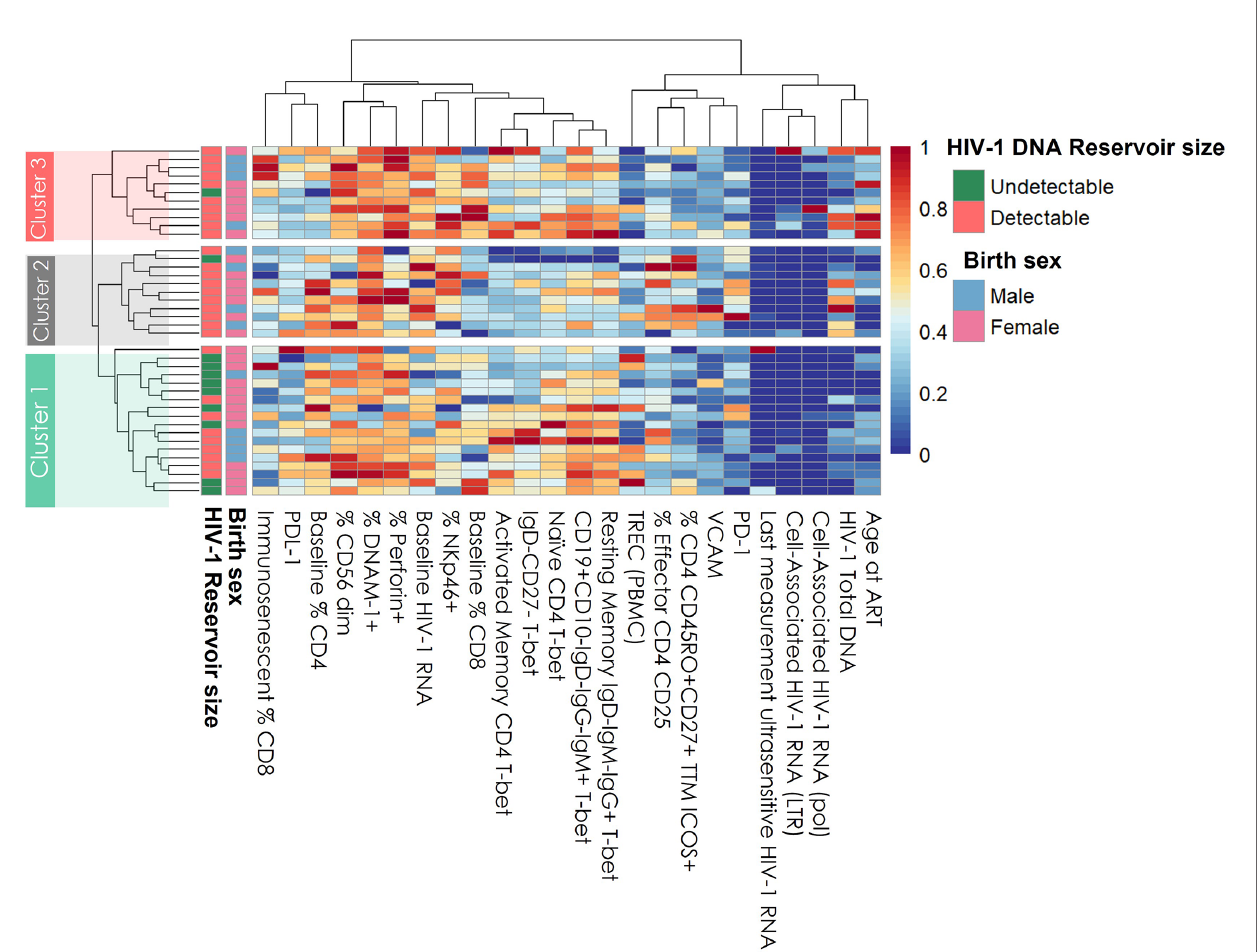
FIGURE 1 | Hierarchical Clustering of all patients based on the clinical, immunological, and virological features. Columns on heatmap represent patient features. Rows are each of the subjects in the study (n = 40). Normalized values are plotted: red color means higher values; blue color means lower values. ART, antiretroviral therapy; VL, viral load; TREC, T-cell receptor excision circle; Undetectable, ≤ 10copies/mL; Detectable >10